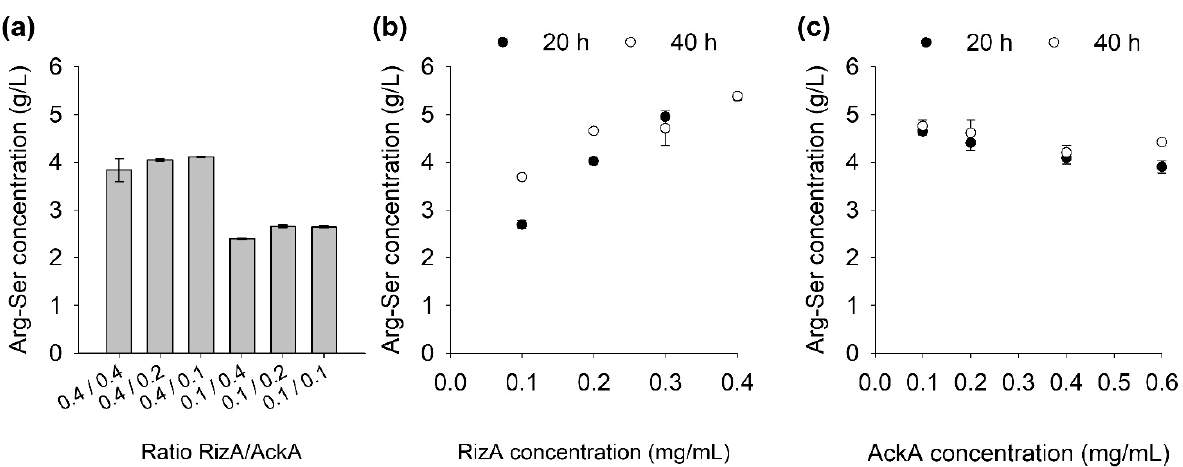
Figure 4. Effect of two enzymes RizA and AckA on Arg-Ser production. ( a ) Ratios of RizA to AckA (both in mg/mL) with 40 mM AA and AcP. ( b ) RizA with 0.2 mg/mL AckA, 50 mM AA and AcP at 20/40 h reaction time. ( c ) AckA with 0.2 mg/mL RizA, 50 mM AA and AcP at 20/40 h reaction time. Reactions were set up in duplicate; data are presented as mean with error bars representing range.